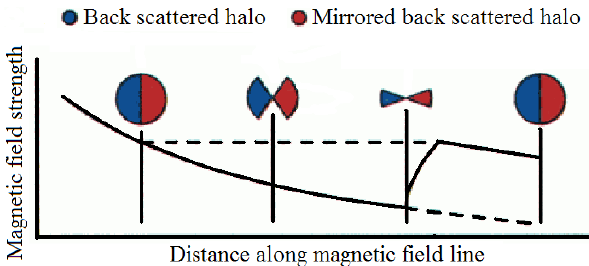
Fig. 1. Schematic illustration of changes in suprathermal electron pitch angle distributions assuming adiabatic evolution along a mag- netic field line with a non-monotonic magnetic strength decrease away from the Sun. See text for details. Adapted from Gosling et al. (2001a) and Skoug et al.